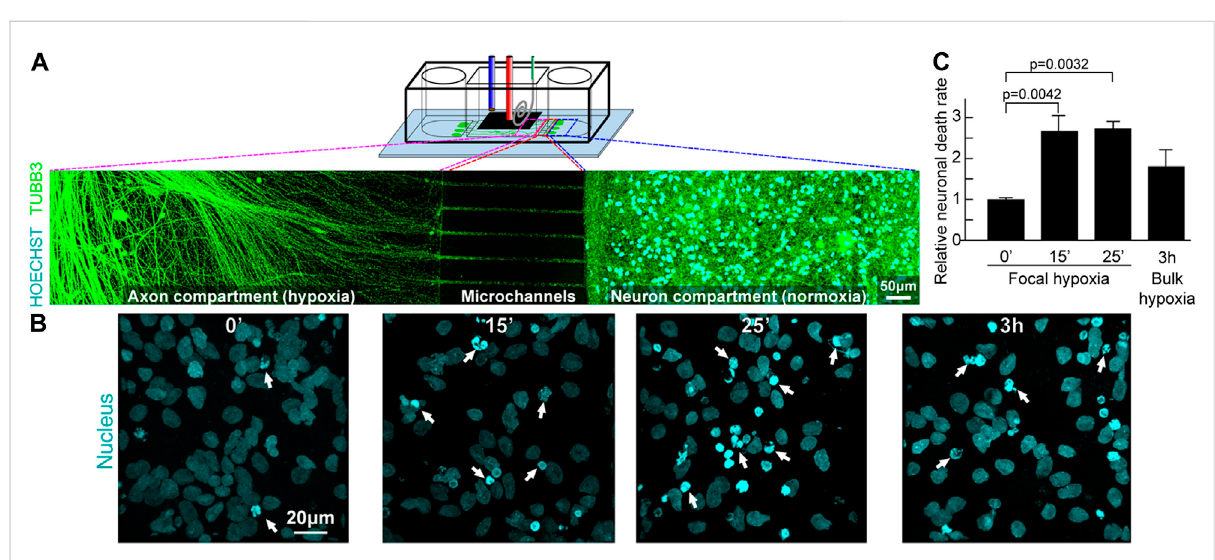
FIGURE 10 Focal hypoxia in a human cortical neuron microchannel model. (A) Schematic presentation of the microchannel model. Representative confocal tile image of neurons growing across the microchannels. Cyan: cell nucleus; green: axons. (B) Representative confocal image of cell nucleus (cyan) at the end chambers and axons in the central chamber after hypoxic insults. (C) Quantitative analysis of cells with chromatin condensation (n =